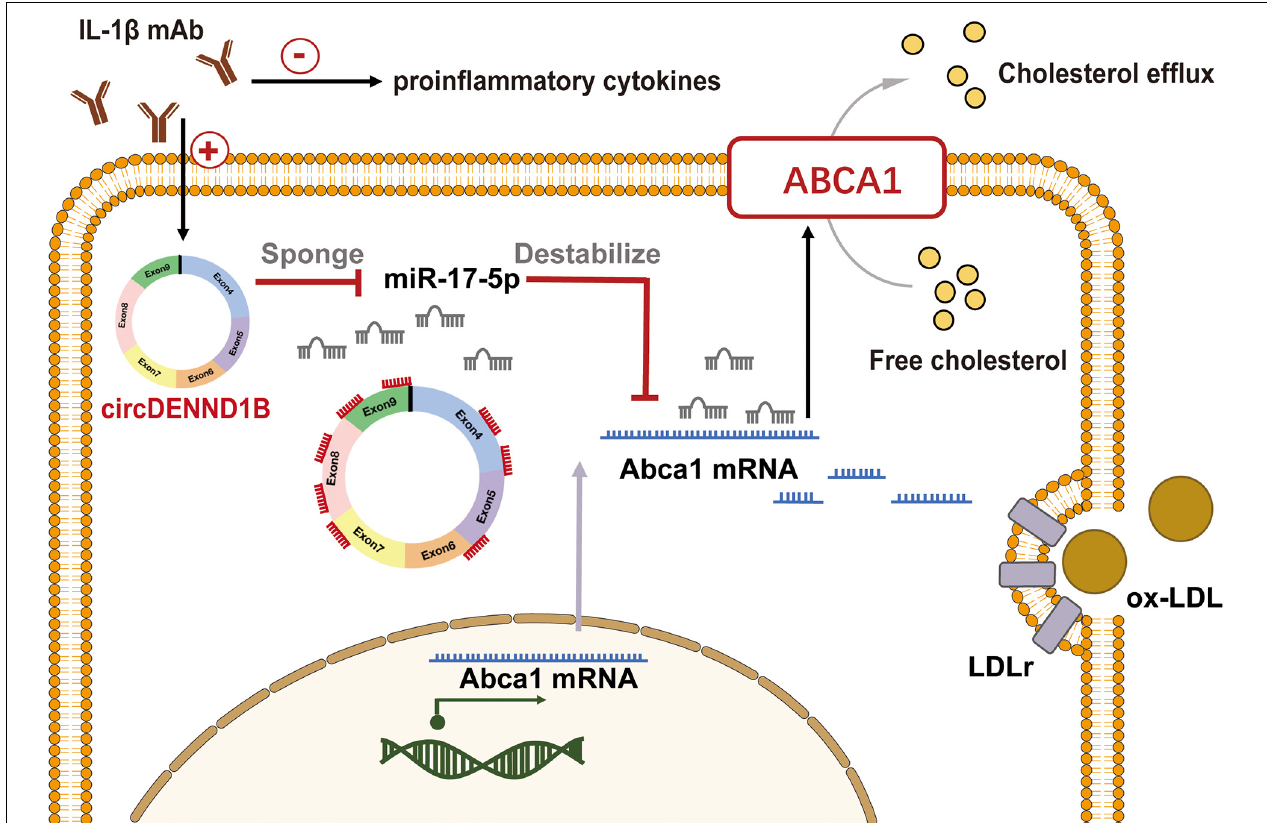
FIGURE 6 | Proposed model of circDENND1B/miR-17-5p/ Abca1 inhibits foam cell formation induced by IL-1 β mAb. Treating macrophages with IL-1 β mAb may increase the expression of circDENND1B, thus inhibit the miR-17-5p- Abca1 pathway. The increased ABCA1 protein would promote cholesterol efflux, and regulate the formation of foam